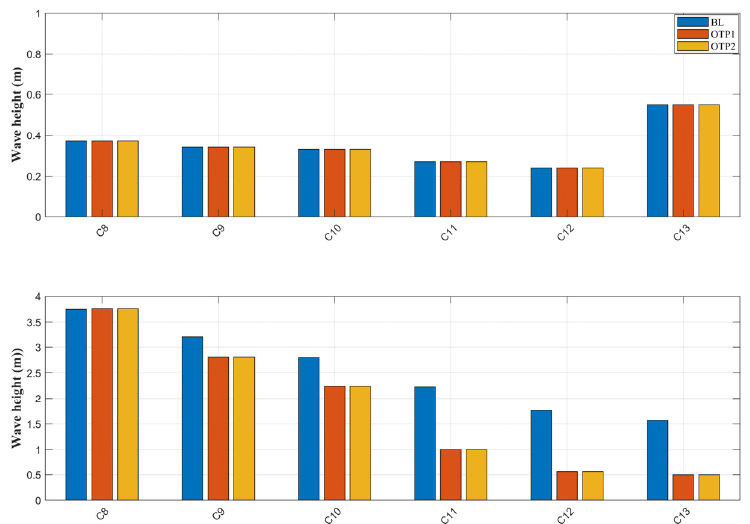
Figure 24. Wave height during the Southeast monsoon ( upper panel) and the storm ( lower